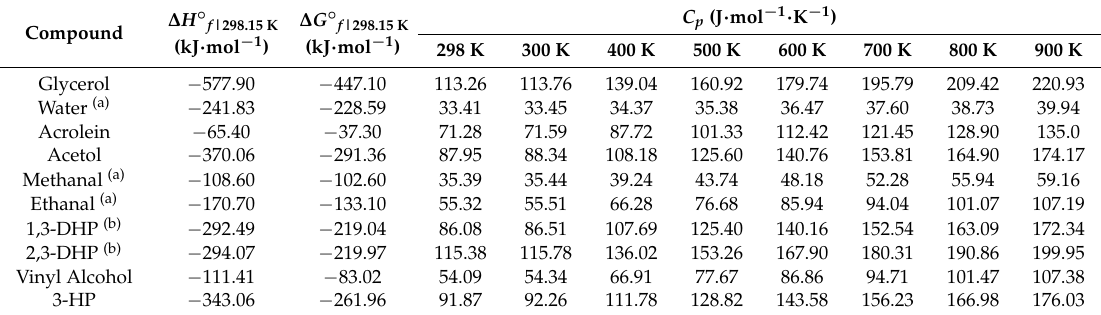
Table A5. Thermodynamic properties of compounds participating in glycerol dehydration. Compound